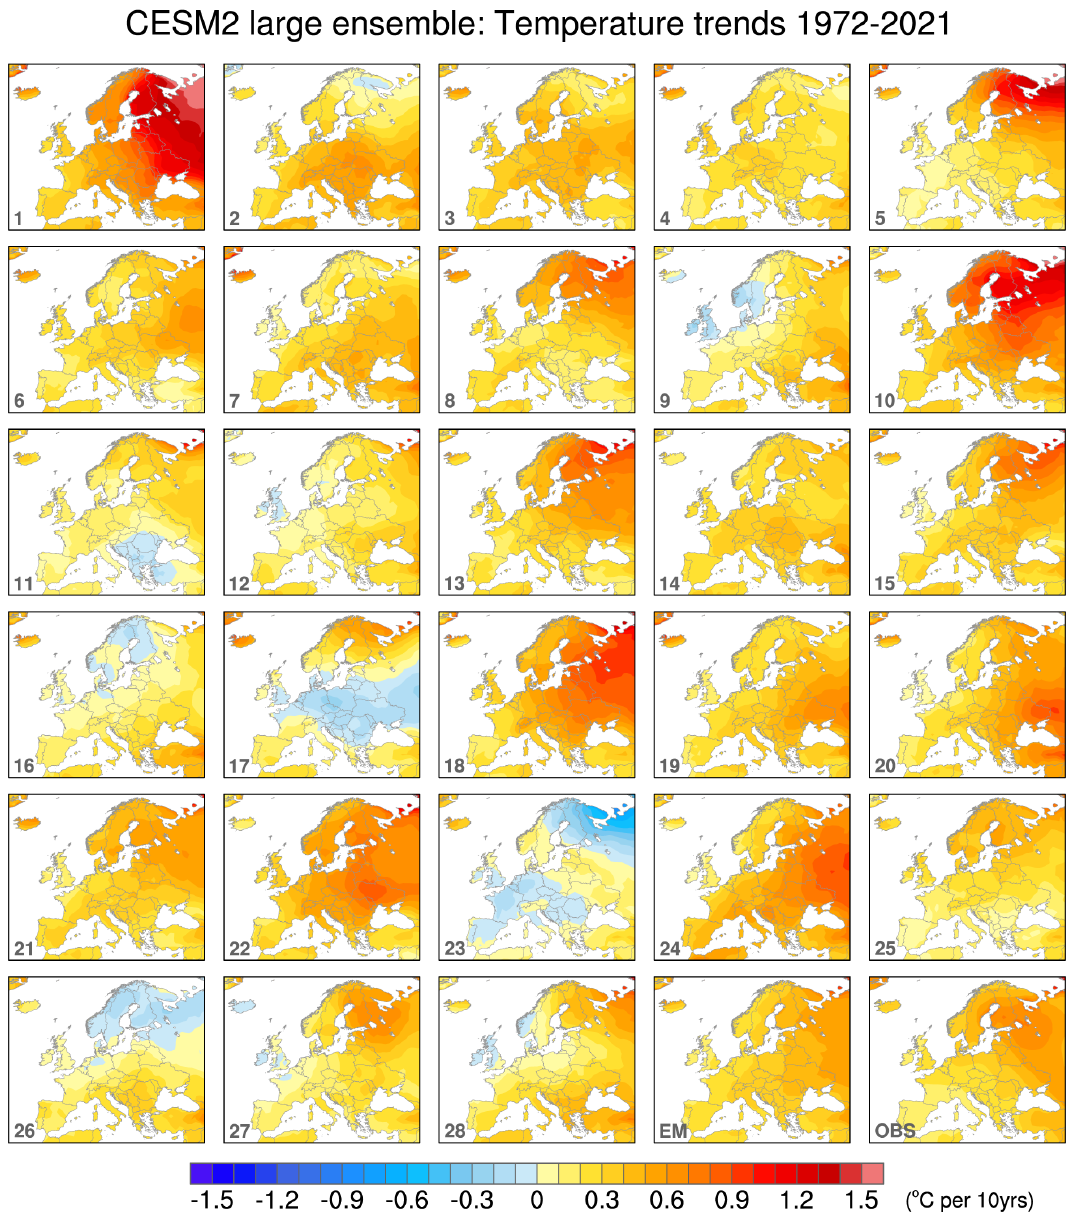
Figure 1. Winter air temperature trends ( ◦ C per decade) for the period 1972–2021, as simulated by the first 28 members of the CESM2 large ensemble (number in the lower left of each panel denotes the ensemble member) and the 100-member ensemble mean (panel labeled EM). Observed trends are shown in the lower right (panel labeled